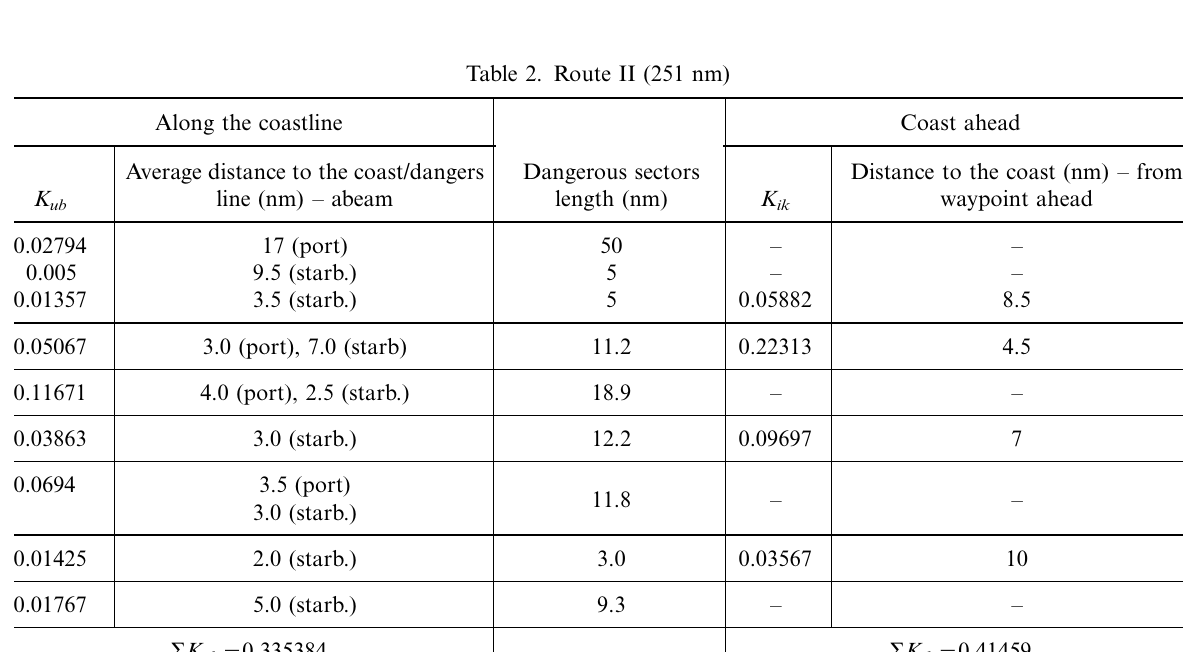
Table 2. Route II (251